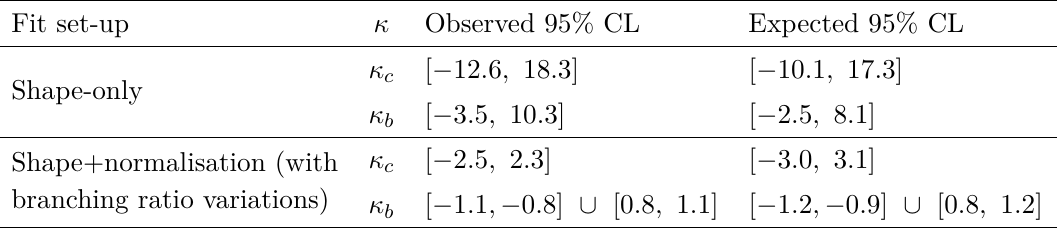
Table 6. Observed and expected allowed ranges at 95% CL of modifications of the b - and c -quark Yukawa couplings to the Higgs boson, κ and κ . The limits on a given κ parameter are computed b c while fixing the other one to its SM value ( κ = 1 ). The table shows the confidence intervals for κ and κ using shape-only and using shape and normalisation variations of the SM c